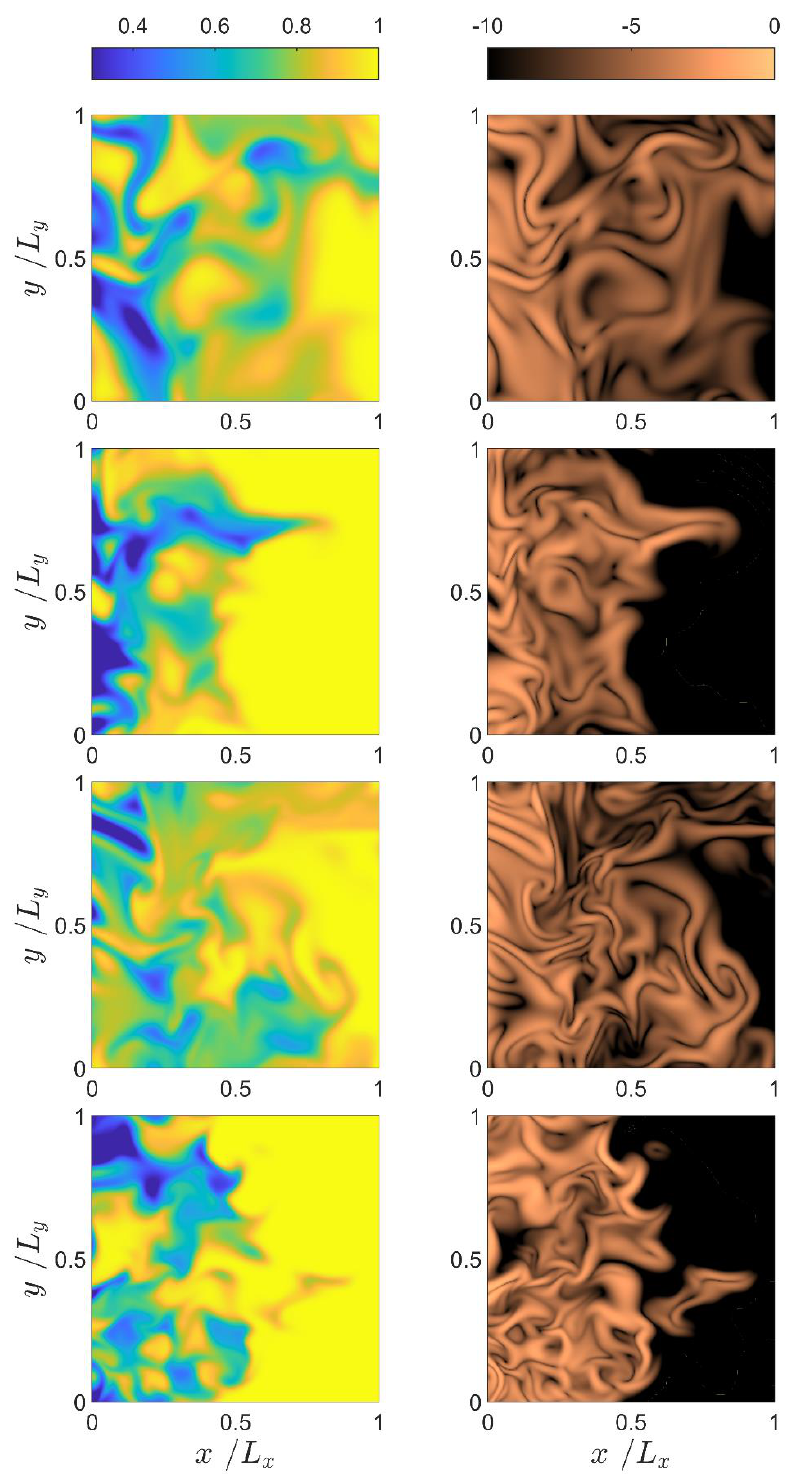
Figure 2. Spatial distributions of 𝑐 based on CH 4 mass fraction (1 st column) and the natural logarithm of its normalised SDR ln (𝑁 𝑐 × 𝑙 0 /𝑢 0′ ) (2 nd column) in the central midplane for homogeneous mixture MILD combustion with 3.5% (1 st and 3 rd row) and 4.8% O 2 concentration (2 nd and 4 th row) for initial 𝑢 ′ /𝑆 𝐿 = 4.0 (1 st and 2 nd row) and 8.0 (3 rd and 4 th row).